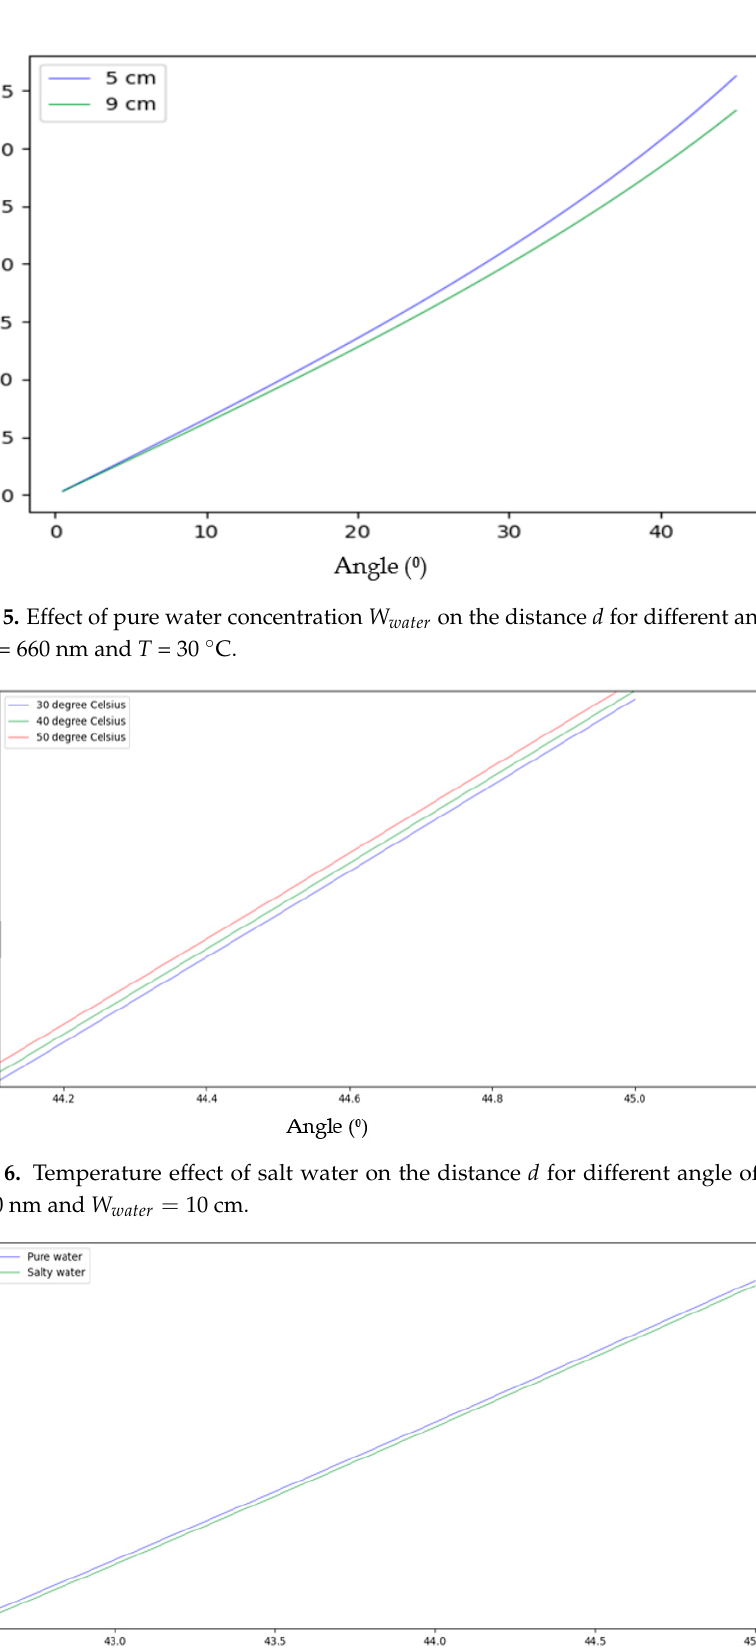
Figure 8. Effect of wavelength on the distance d of pure water sample for different angle of incidence 𝜃 (cid:3036) at T = 30 °C and 𝑊 (cid:3050)(cid:3028)(cid:3047)(cid:3032)(cid:3045) = 5 cm . 4. Results and Discussion Figures 5–8 show that all the factors used are generating a specific “fingerprint” or change in data input parameters, which is then used to generate a machine learning model based on those points as a variable input parameter. The “fingerprint” term here means that a specific pattern of input-output data is unique, as demonstrated previously by changes in the distance d and its dependence on other input parameters. This assures that the MLP model can fit input to output because no input set is unique. Tables 4 and 5 show the MLP training/testing errors and accuracy parameters. In Table 4, the error outputs parameters show that the MLP model accuracy is very high with 𝑅 (cid:2870) = 0.844 and the mean absolute error is 0.156. This demonstrates that the proposed MLP model can be used for input-output mapping purposes. To make the data more interesting, Table 4 shows a tabular form of the data with new input parameters and MLP predictions, along with the corresponding error or classification. It is important to